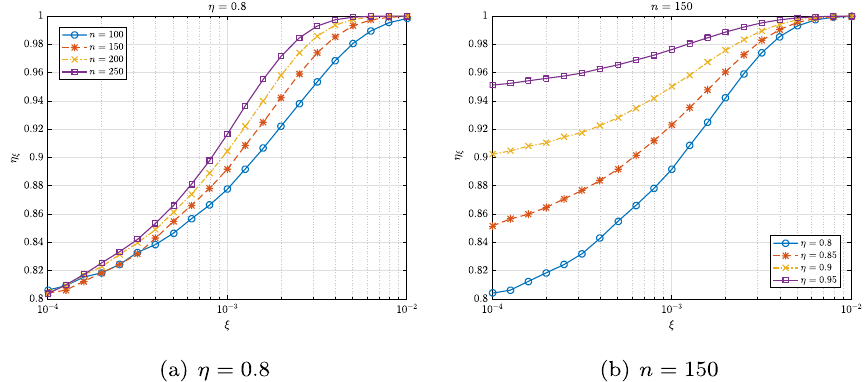
Fig. 7 Relationship between ξ and η ξ . The figure presents the relationship between ξ and η ξ : a η = 0.8 and n ∈ { 100,150,200,250 } ; b n = 150 and η ∈ { 0.8,0.85,0.9,0.95 } . We can quantify the modification effect on the forwarding graphs through the relationships between ξ and the successful receiving probability of SCPs η ξ = ¯ r / n at a IIoT node. We observe that the larger the value of n is, the faster η ξ increases as ξ grows. Also the contribution of the increasing of ξ is much higher with a smaller